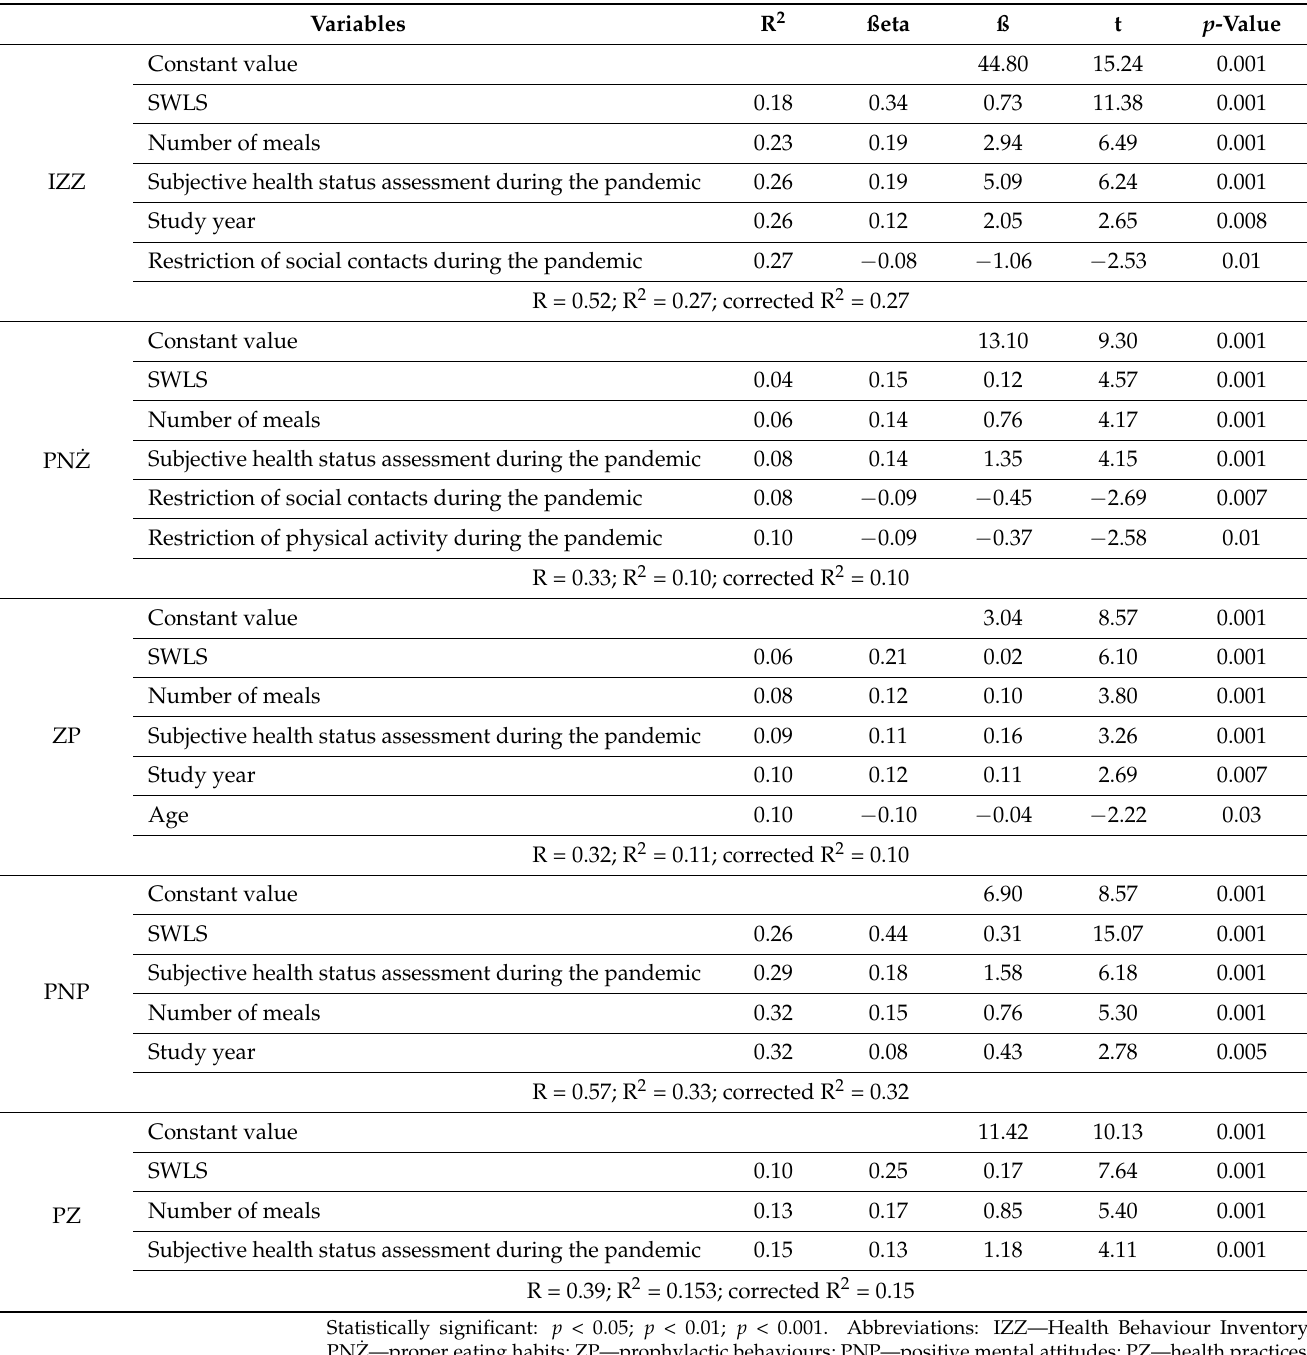
Table 3. Health behaviour